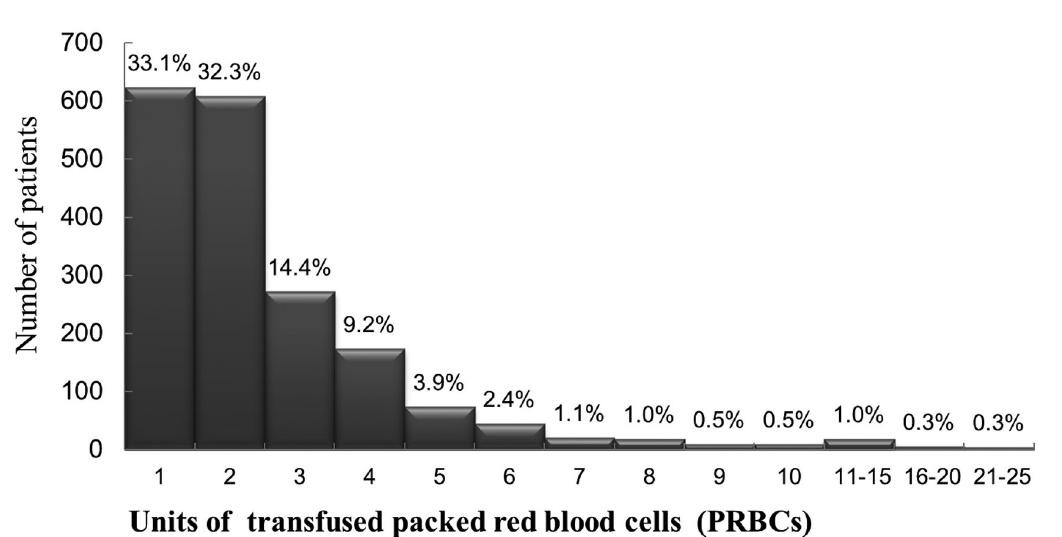
Fig. 1 - Frequency histogram of the packed red blood cells units